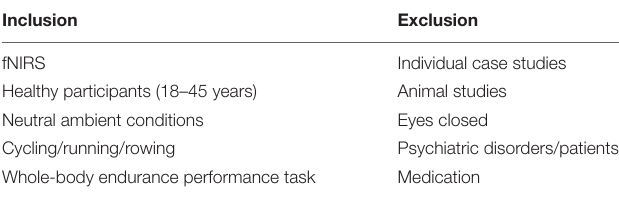
TABLE 3 | Inclusion and exclusion